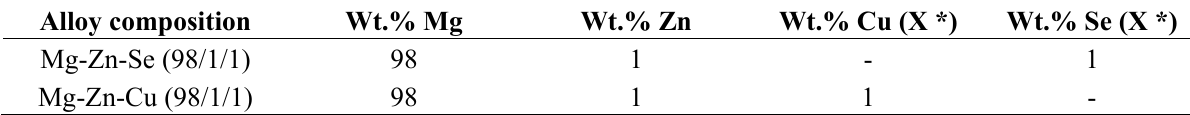
Table 3. Composition of ternary magnesium alloys.